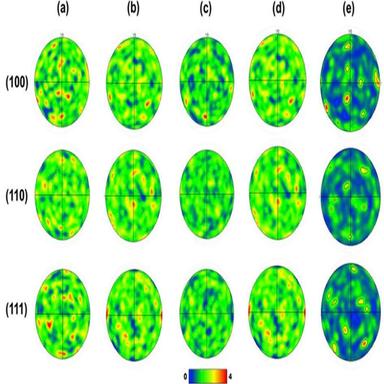
Pole figures of Ni foams fabricated by freeze casting NiO slurry containing 5 vol% and 7 vol% NiO powder, (a, c) parallel and (b, d) perpendicular to the freezing direction, and (e) commercially available Ni foam.